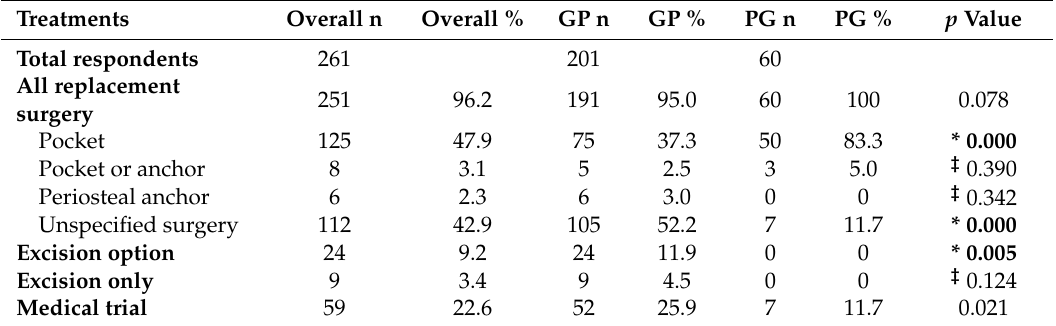
Table 3. Canine PNG treatments recommended by GP and PG groups responding to a vignette questionnaire.